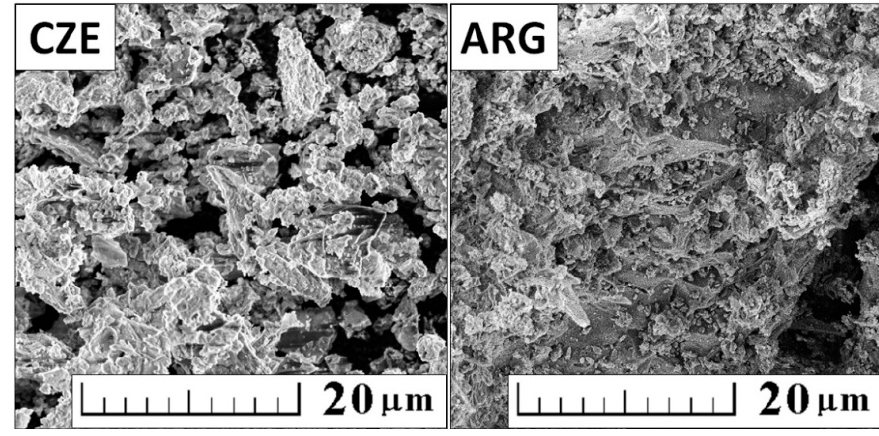
Figure 2. Morphology of ceramic powders obtained by SEM.